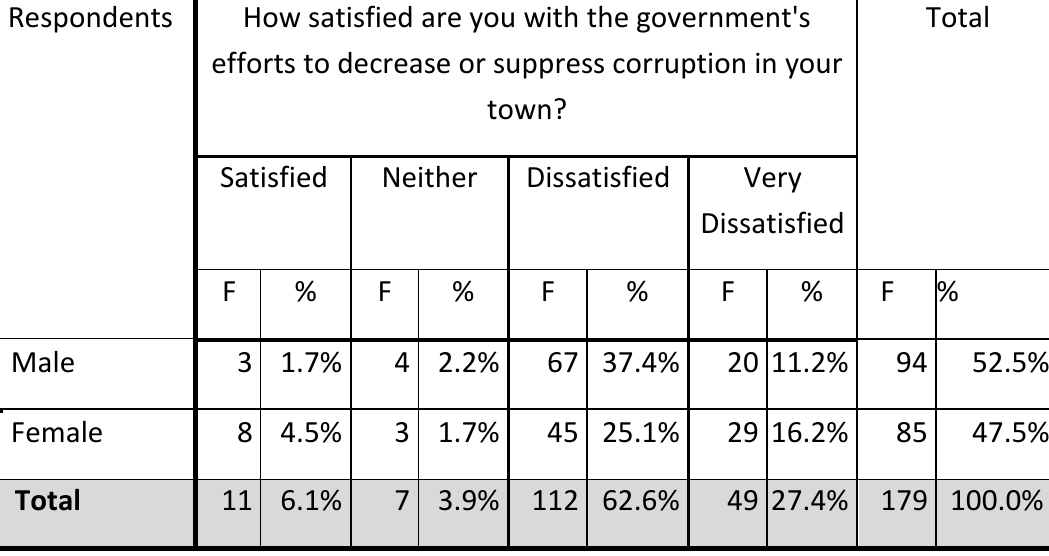
Table 20: Citizens were asked to indicate their level of satisfaction regarding the local government’s effort in combating corruption in the town Respondents